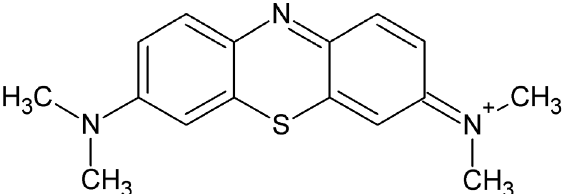
Figure 1 - Chemical structure of methylene blue.